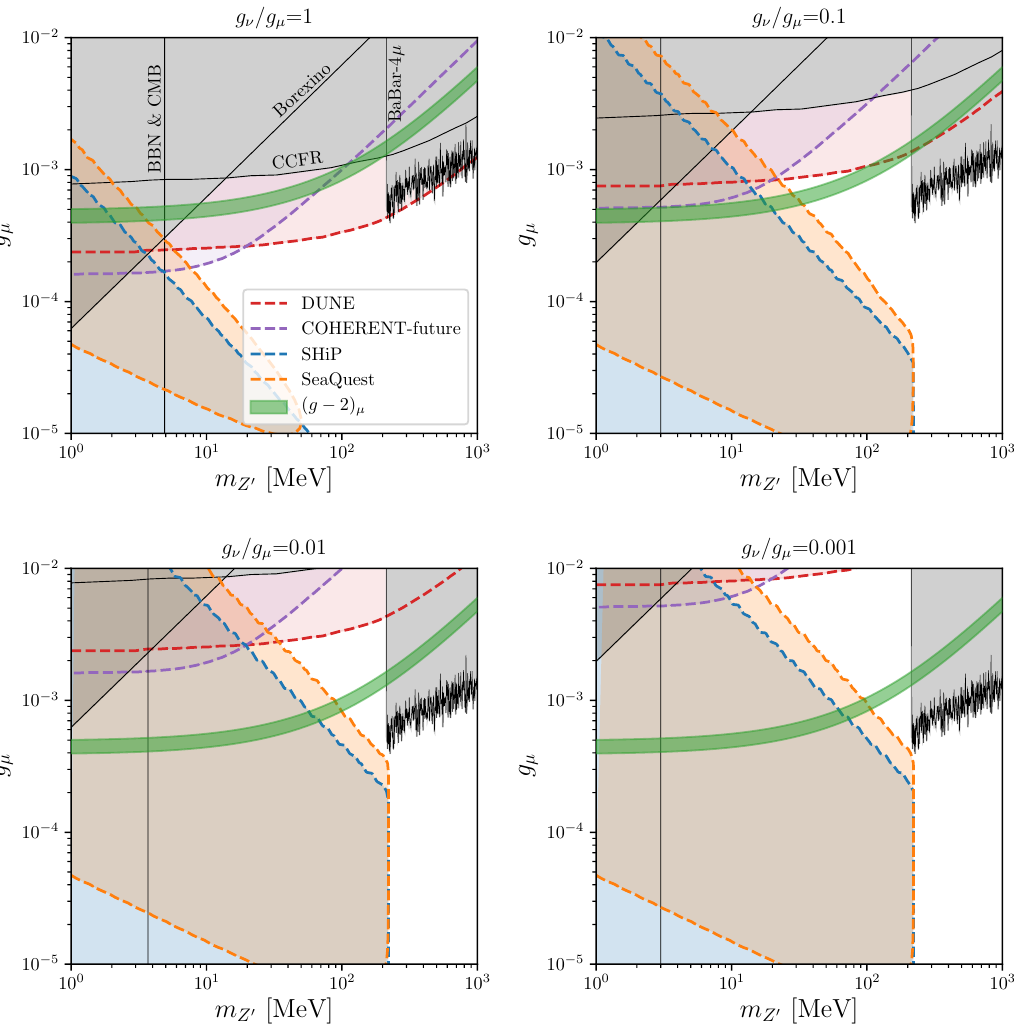
Figure 6 . Prospects of future BD and neutrino experiments probing the Z 0 solution to the muon g − 2 anomaly. Existing bounds are shaded grey and outlined by solid black lines, while the expected future bounds are coloured and have dashed borders. The upper left panel assumes g states the different bounds in the figure, the other panels with g the same conventions. Couplings of Z 0 to the electron and quarks are assumed to be at the loop- induced level given by eq.